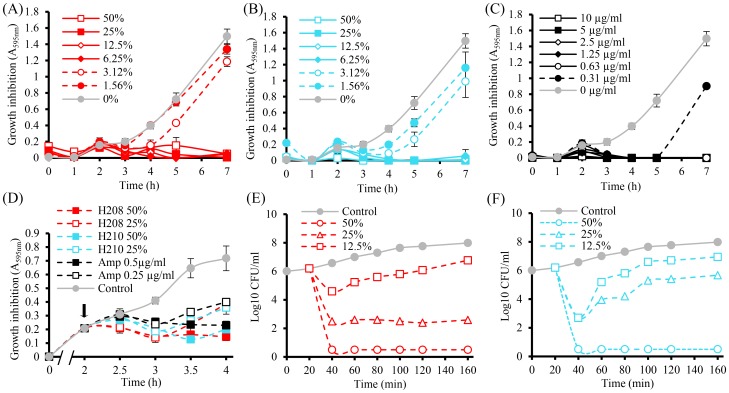
Kinetics of growth inhibition of lag-phase and log-phase E. coli exposed to honeys and ampicillin (A,B,C) and (D), respectively, and time-kill kinetics (E, F).The arrow indicates the application time of honeys or ampicillin into log-phase E. coli. In A to D, each point represents the mean ± standard deviation (n = 9), in E and F (n = 4).